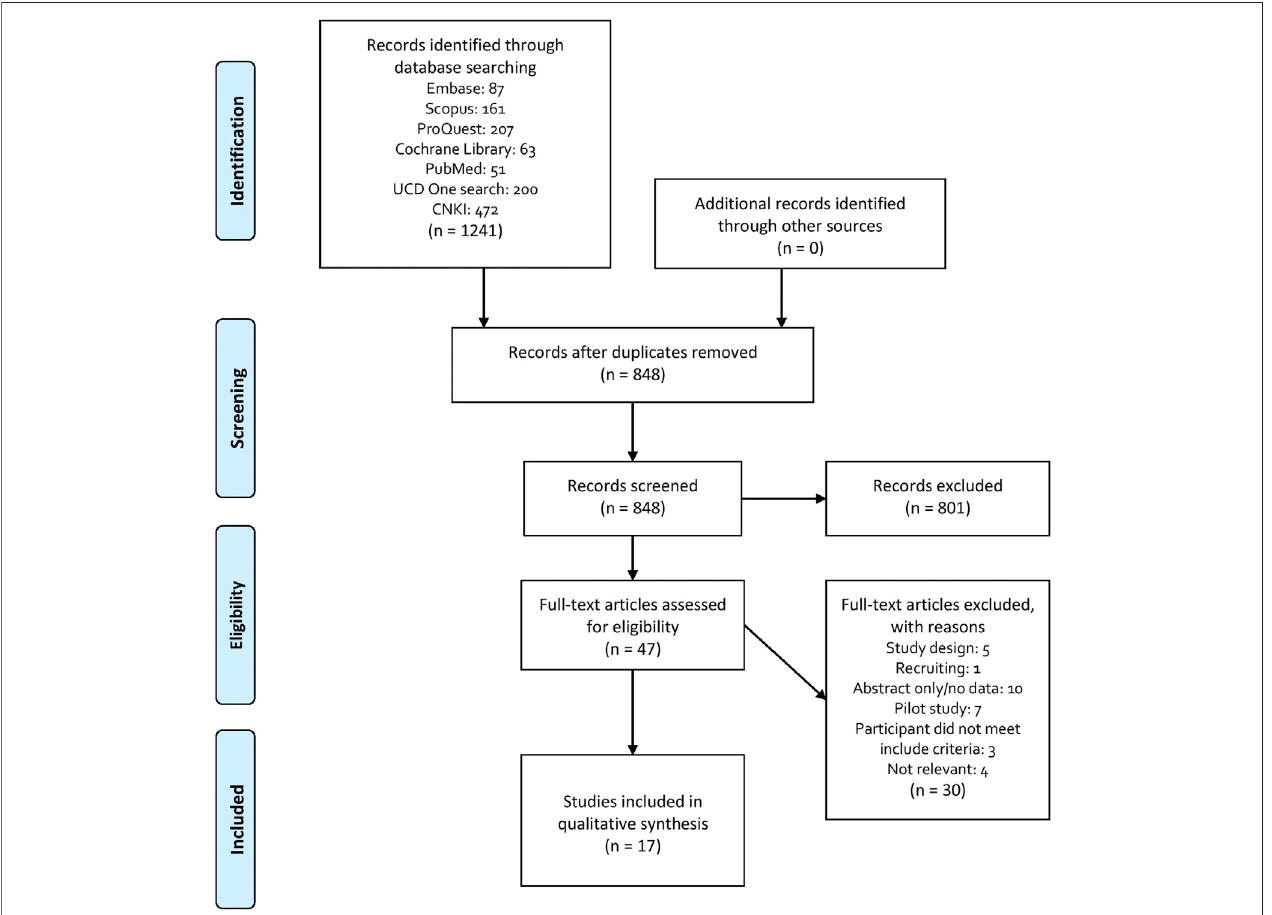
FIGURE 1 | PRISMA fl